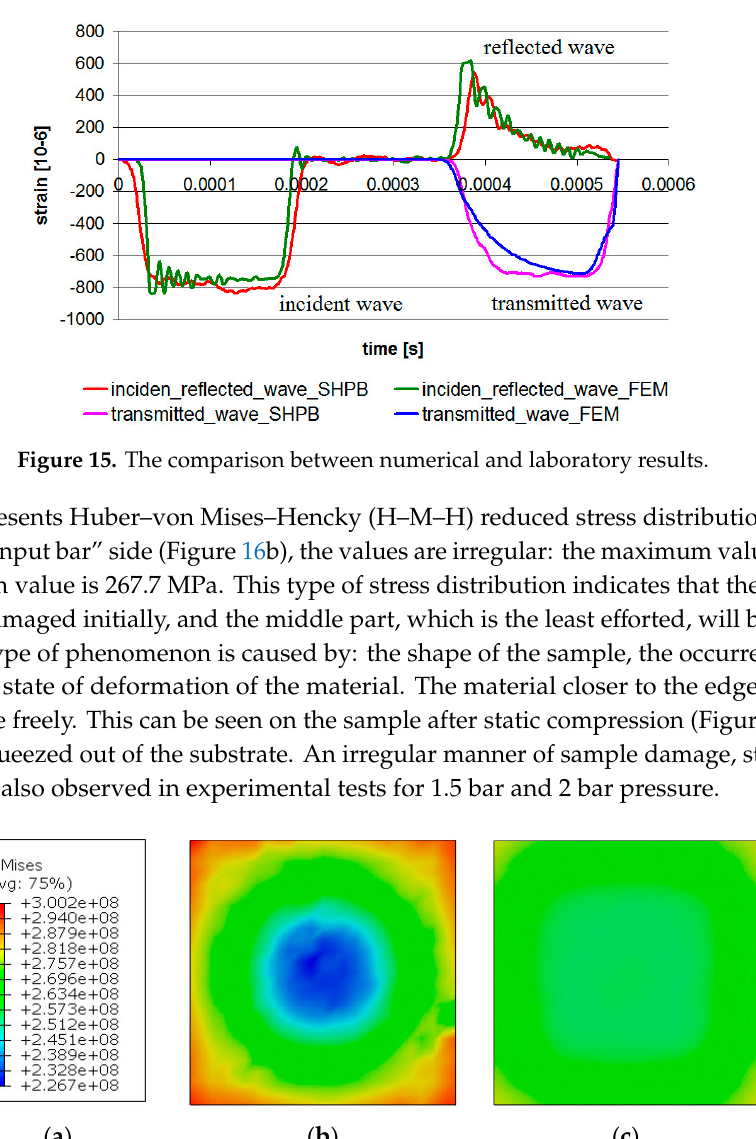
Figure 14. Mesh of finite elements. ( a ) sample between bars ( b ) layers of sample.